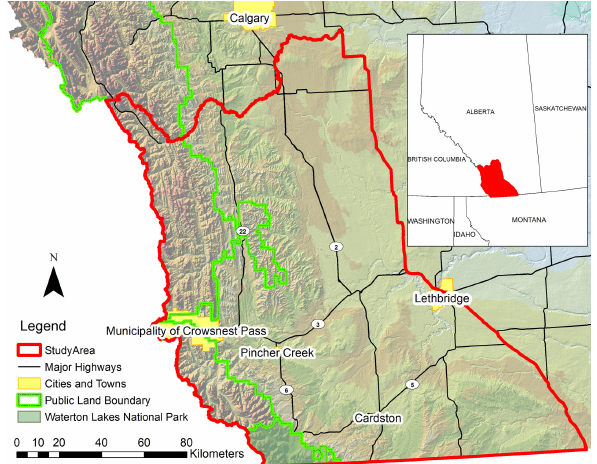
Fig. 1 . Map of study area in southwestern Alberta. The Municipality of Crowsnest Pass is a linear series of small towns along the Highway 3 transportation